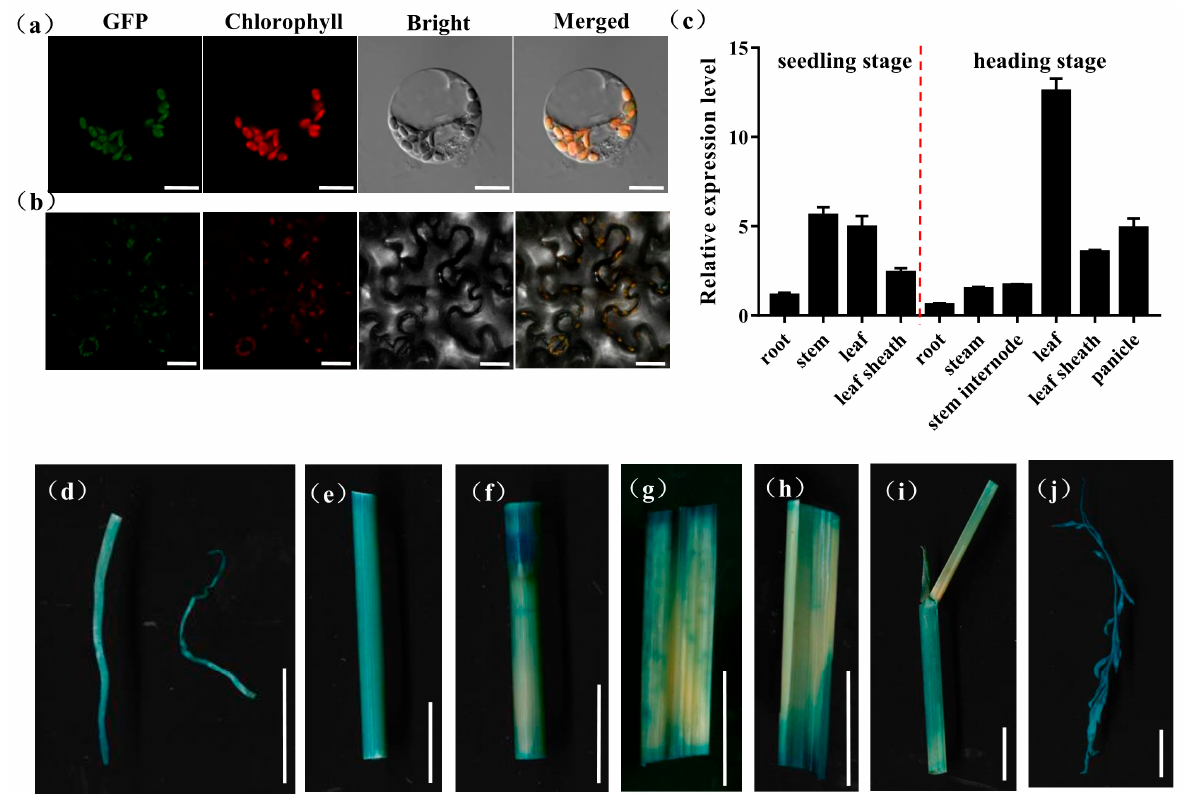
Figure 6. Expression patterns of OsPHD1 . ( a ) Transcript levels of OsPHD1 in different organs of WT at the seedling stage and the heading stage. ( b , c ) Subcellular localization of OsPHD1 protein. ( b ) Rice protoplast transient assay. Scale bars, 10 µ m. ( c ) Nicotiana benthamiana leaf assay. Scale bars, 50 µ m. ( d – j ) Histochemical signals in plants carrying the OsPHD1 promoter–GUS reporter gene. ( d ) root, ( e )stem, ( f ) stem internode, ( g , h ) leaf, ( i ) leaf sheath, ( j ) panicle. Scale bars, 1